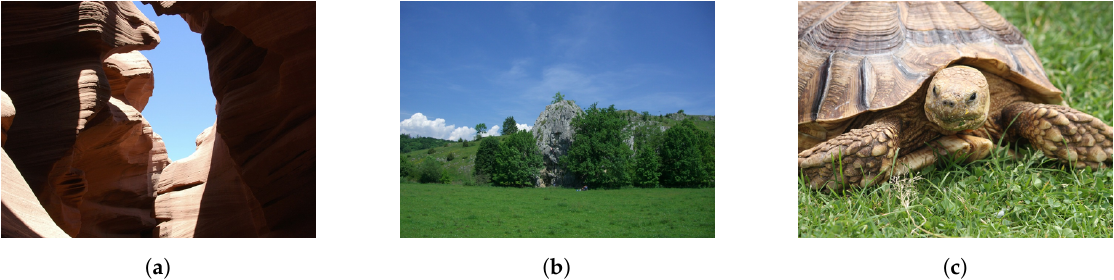
Figure 7. Sample images form the KADIS700k databases. ( a – c ) random photos from